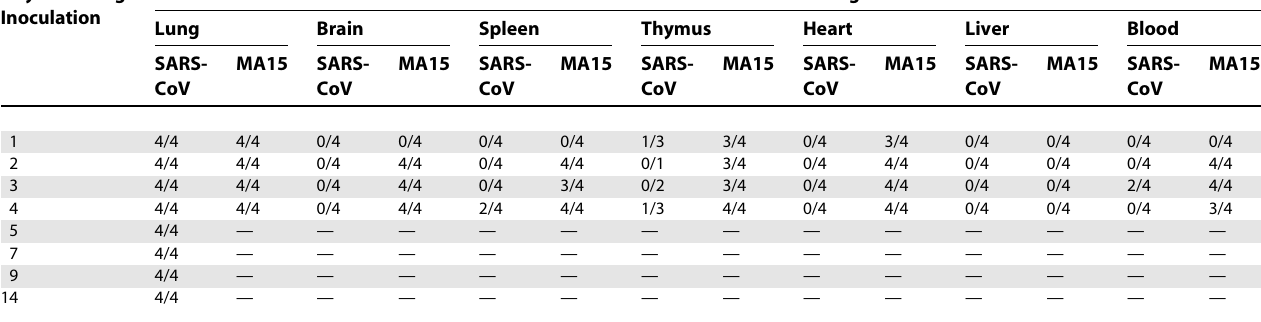
Table 4. Detection of SARS-CoV and MA15 vRNA Day following Number of Mice in Which RNA Was Detected/Number Tested in Indicated Organ Inoculation Lung